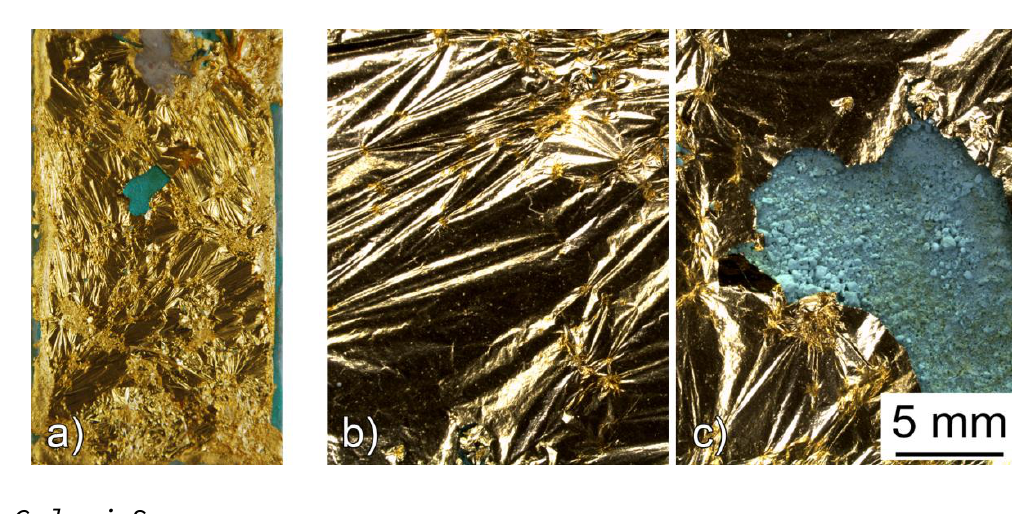
Figure 8. Macroscopic (sensors max. length: 60 mm) ( a ) and microscopic documentation ( b , c ) of a galvanic sensors showing a lack of adhesion of the gold